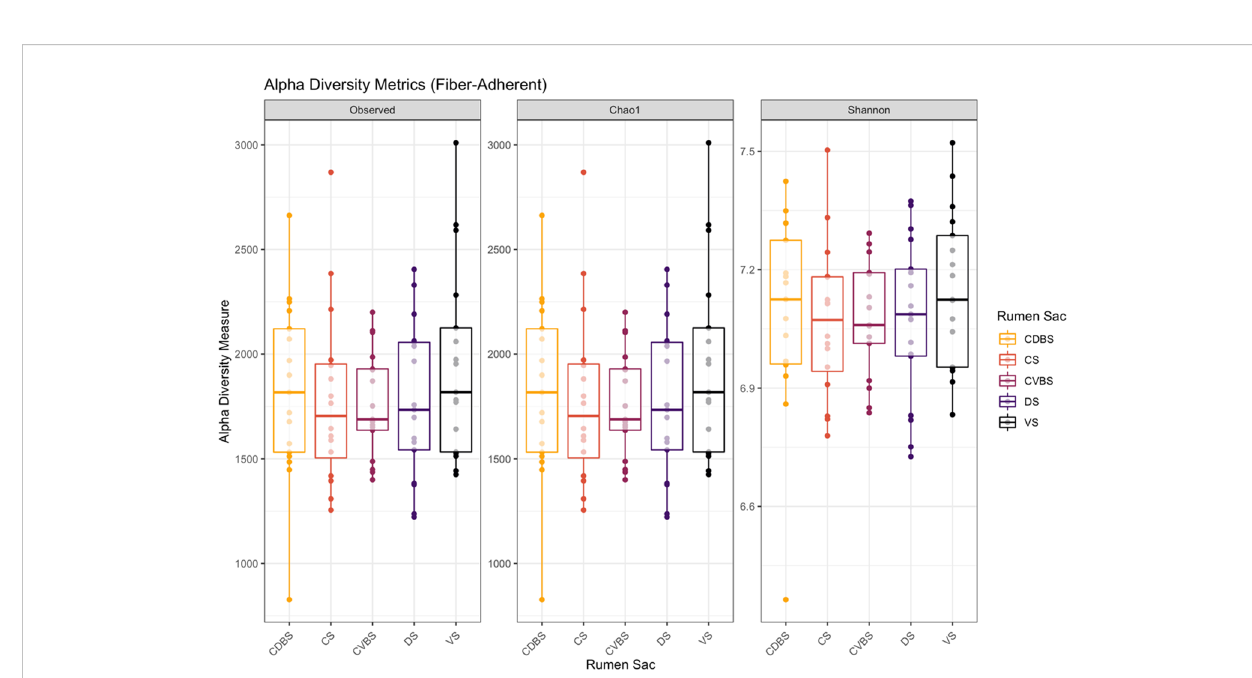
FIGURE 5 Alpha diversity metrics in the fi ber-adherent fraction among the fi ve rumen sacs. Alpha-diversity metrics for fi ber-adherent bacterial communities among each of the fi ve rumen sacs. Measures were observed ASVs (richness), Chao1 (expected richness), and Shannon diversity index (richness and evenness). The CDBS is denoted by orange, CS is denoted by red, CVBS is denoted by light purple, DS is denoted by dark purple, and VS is denoted by black. With the removal of singletons during data analysis, the Chao1 measurement may appear similar to the observed measurement. No signi fi cance was determined within the fi ber-adherent microbial community among the rumen sacs (P > 0.05).